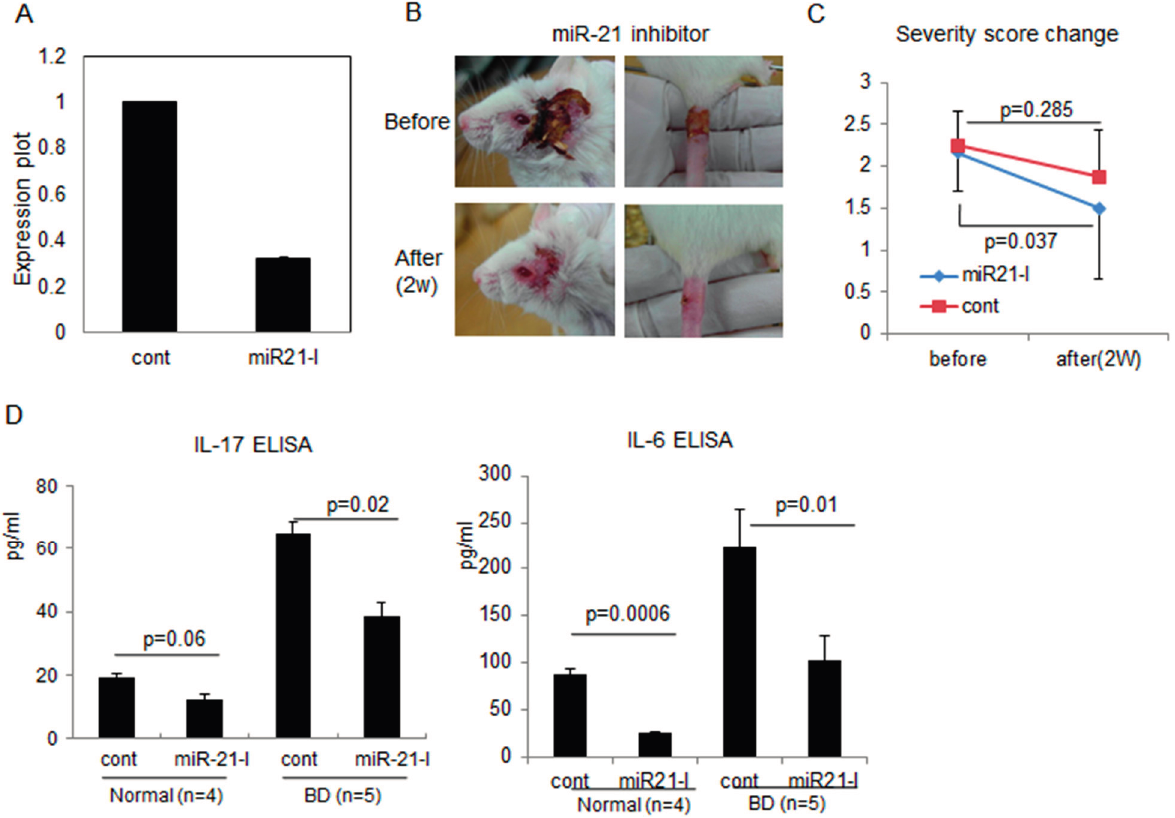
Figure 3. miR-21 antagomir (miR-21 inhibitor, miR21-I) inhibited miR-21 expression ( A ); improved BD-like symptoms ( B ); and decreased BD severity score ( C ) as well as serum levels of IL-17 and IL-6 ( D